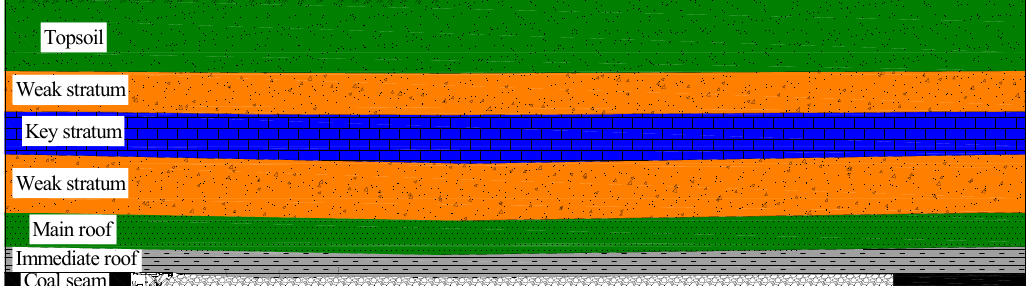
Figure 2. Features of overburden strata movement in coal mining with compacted backfilling (CMCB) method [11].